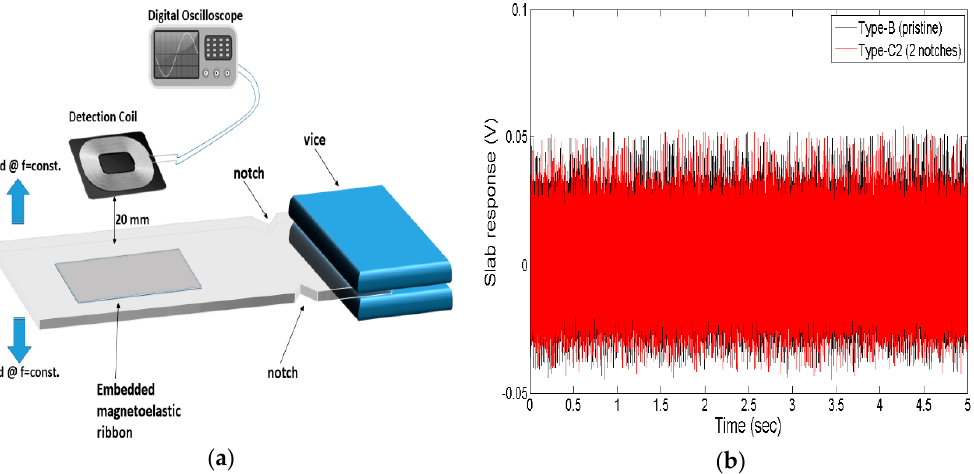
Figure 4. ( a ): Single cantilever arrangement for testing type-B, -C1 and -C2 slabs. ( b ): Response of type-B and -C2 (the most damaged) slabs (in V) versus time.